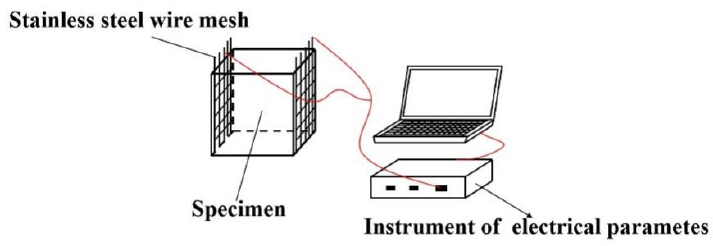
Figure 1. The measuring process of electrical parameters.